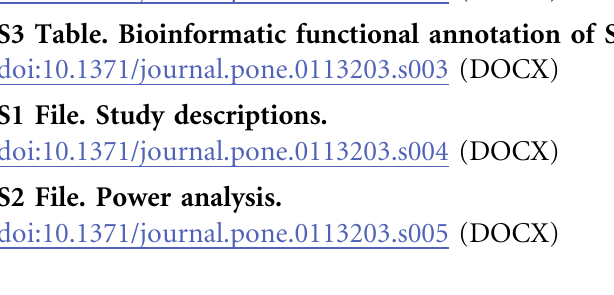
S1 Table. Demographic characteristics of the African American individuals from studies with incident CHD events. S2 Table. Associations of secondary signals in validated CHD loci with incident coronary heart disease in African Americans. S3 Table. Bioinformatic functional annotation of